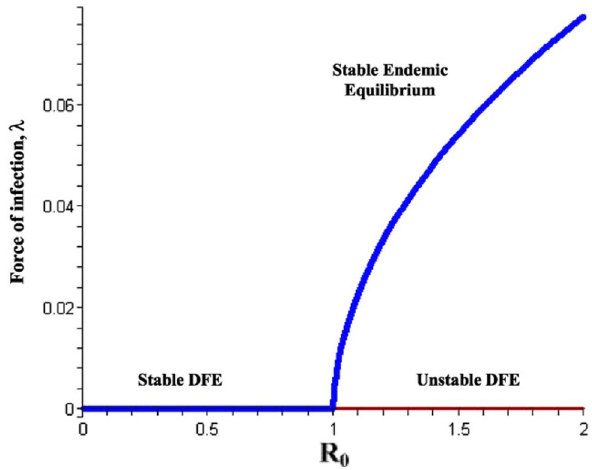
Figure 4. Forward bifurcation.